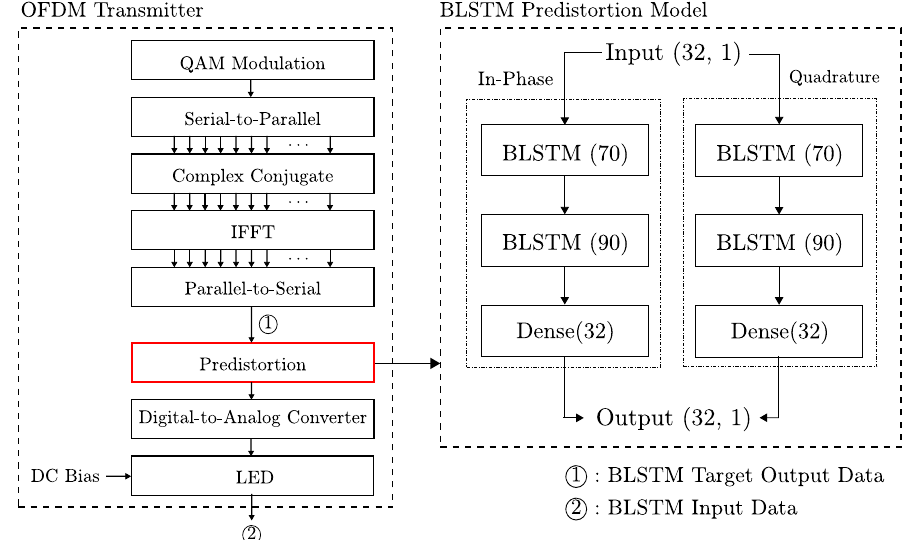
Figure 7. An Initial design of Bidirectional LSTM in predistortion module from OFDM transmitter. Note that, for training model, we consider input data as 2 (cid:13) and target output as 1 (cid:13)